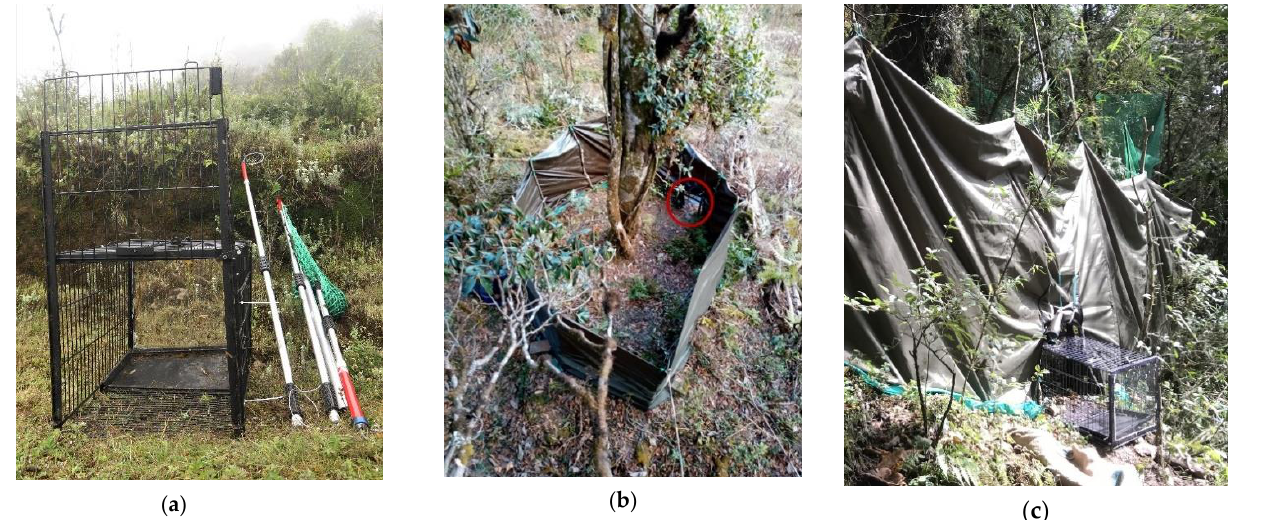
Figure 2. ( a ) Trapping instruments: cage trap, trapping poles, and net. ( b ) Fence built around a tree with a red panda. The fence was nearly 2.5 m high, built using a canvas sheet around the tree. Bamboo and wooden pegs were used to support the fence. This canvas sheet weighed nearly 25 kg. The cage trap (highlighted with a red circle) was placed downslope of the enclosure. ( c ) A view of the cage trap from outside the enclosure.